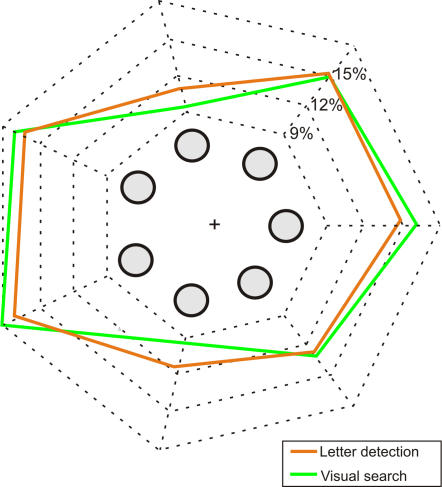
Effect of position.Radial plot showing the proportion of objects detected in each position on the display for visual search (green) and letter detection (orange) in the dual task. CVS items and letters located on the horizontal meridian were detected more often. Item positions on the graph correspond to the positions in the display as seen by subjects.